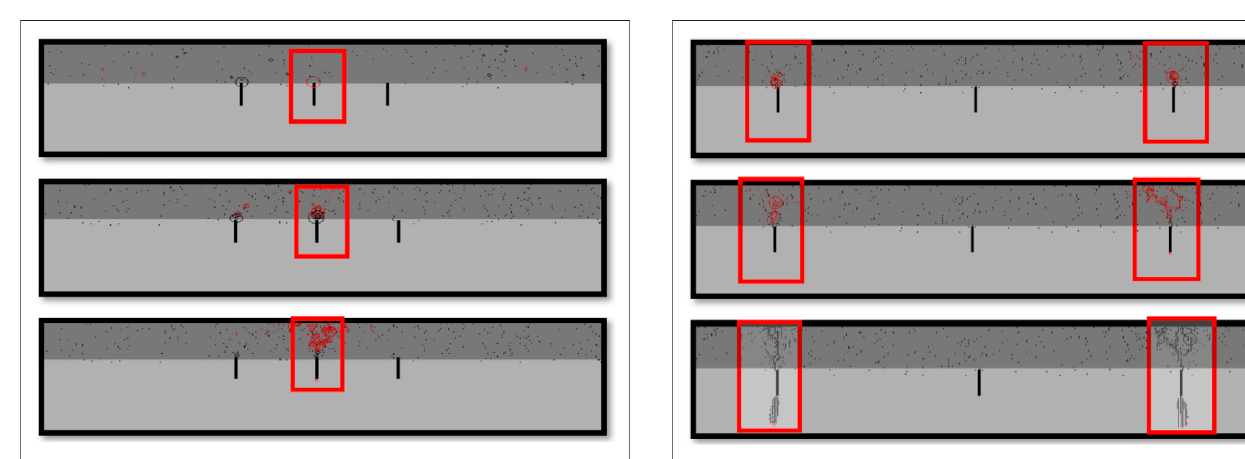
FIGURE 12 | Distribution of AE during formation of re fl ection cracks when S/T = 1.25.